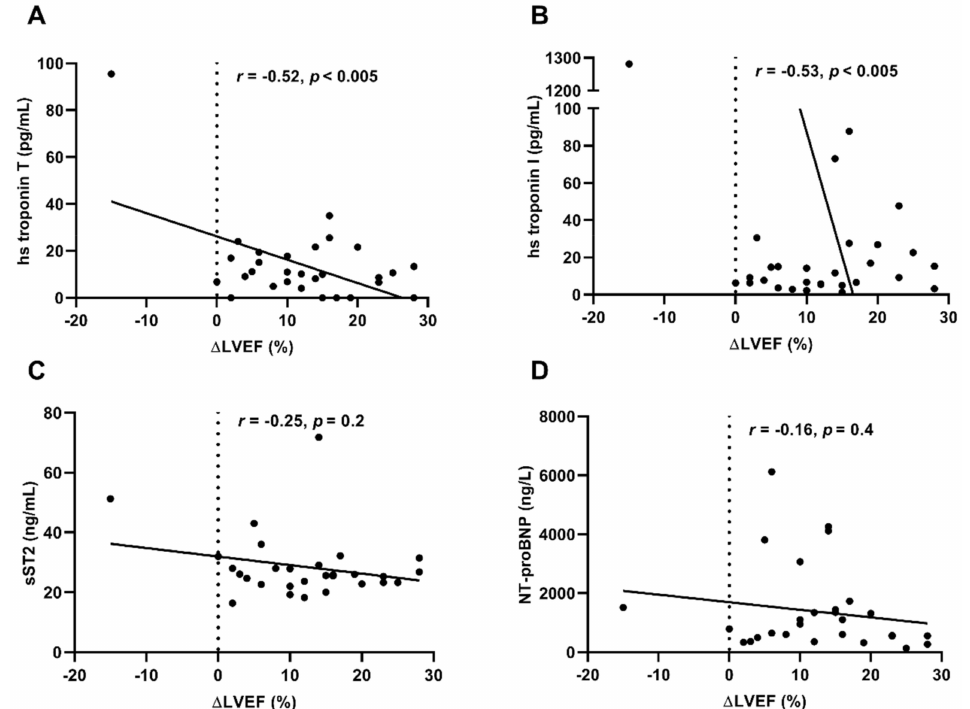
Figure 5. Correlation of HF biomarkers with ∆ LVEF. Hs troponin I ( A ) and T ( B ) showed a negative correlation to the improvement of LVEF during long-term follow-up. In contrast, sST2 ( C ) and NT-proBNP ( D ) showed no correlation with ∆ LVEF. Each sign represents one patient, linear regression is illustrated by the graph, n = 29. ∆ LVEF = improvement of LVEF from before immunoadsorption to long-term